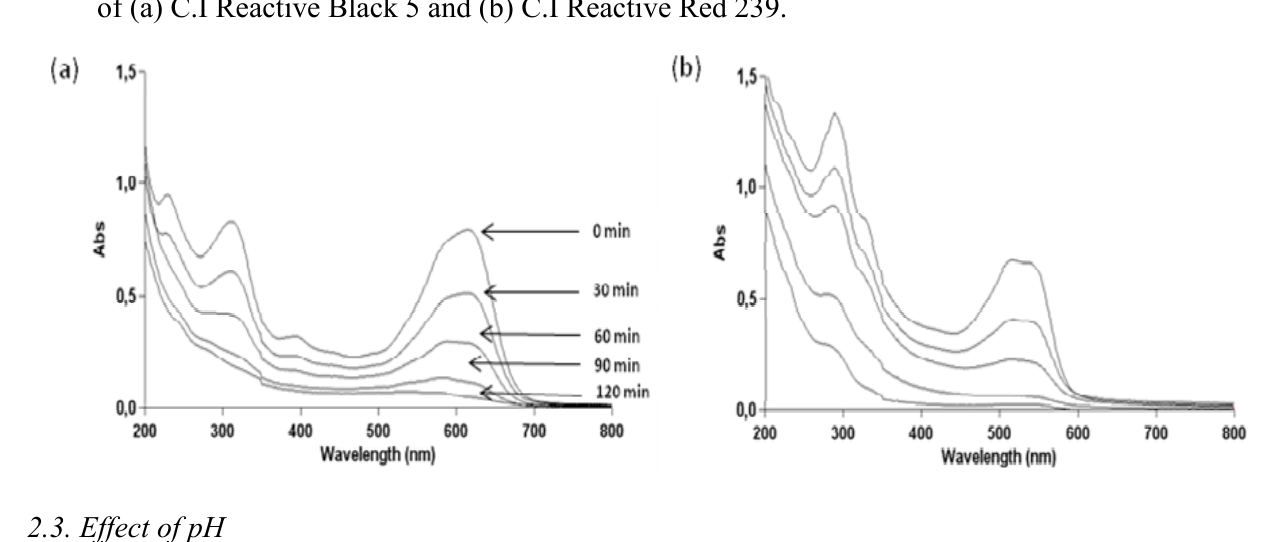
Figure 4. Photocatalytic degradation under 125 W mercury-vapor lamp irradiation with 0.1 g·L − 1 of TiO followed by UV-Vis spectrophotometry from 200 to 900 nm for 30 mg·L − 1 2 of (a) C.I Reactive Black 5 and (b) C.I Reactive Red 239.